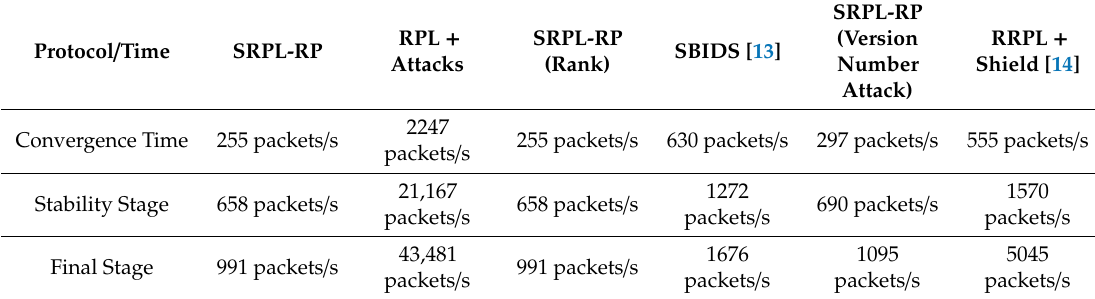
Table 8. Control Message Comparison in Random Topology.